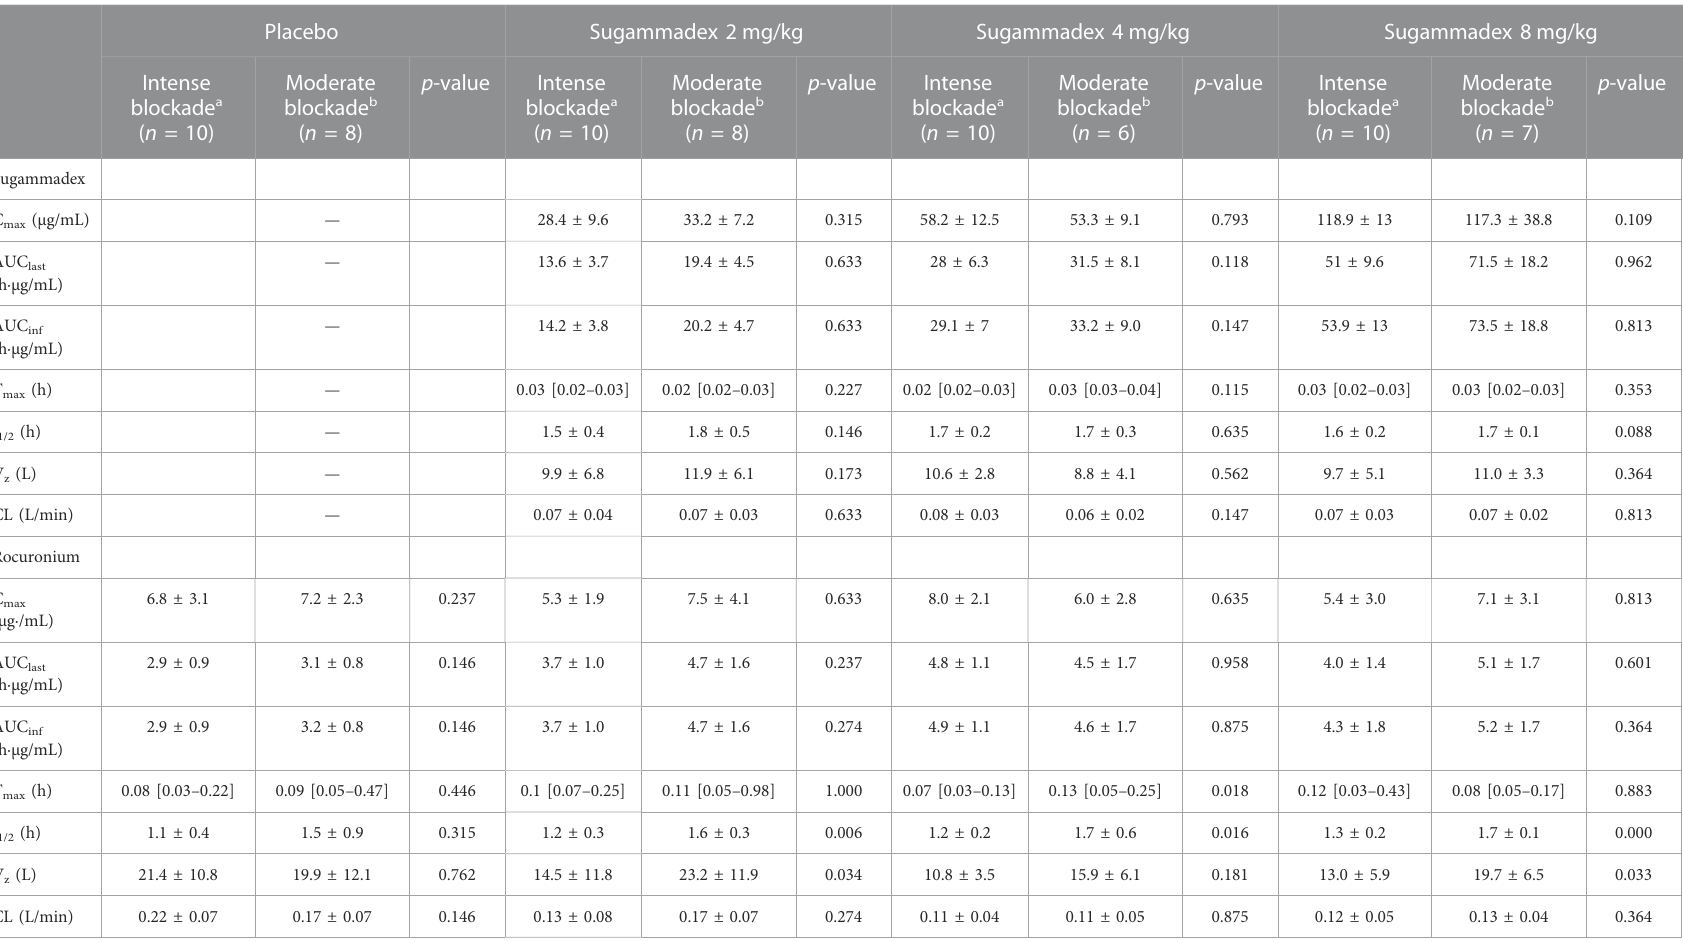
TABLE 2 Summary of pharmacokinetic parameters including comparison with previous